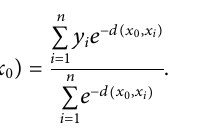
Frontiers in Environmental Science |